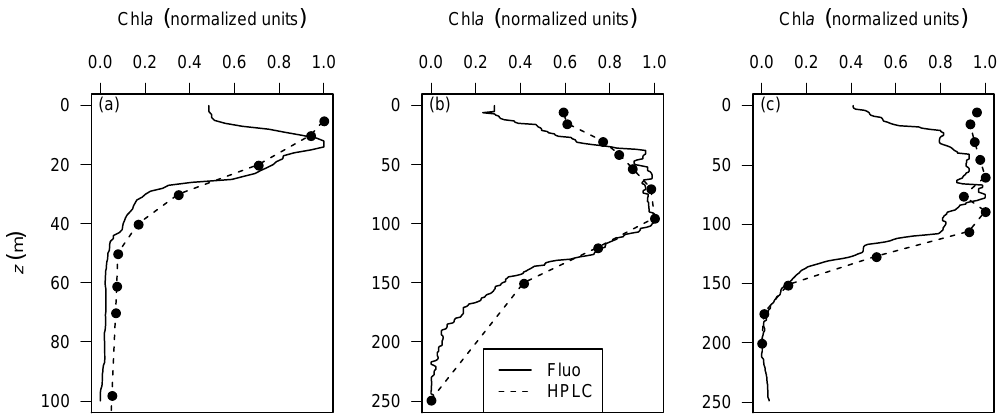
Fig. 9. Fluorescence profile (plain line) and HPLC Chl- a profile (dashed line, black dots) in three typical situations of quenching. The fluorescence and Chl- a units are normalized (between 0 and 1). (a) POMME2 cruise at 7.898 ◦ W, 43.369 ◦ N on the 11 of April 2001. (b) BIOSOPE cruise at 86.78 ◦ W, 32.40 ◦ S on the 1 December 2004. (c) OLIPAC cruise at 149.99 ◦ E, 1 ◦ N on the 15 November